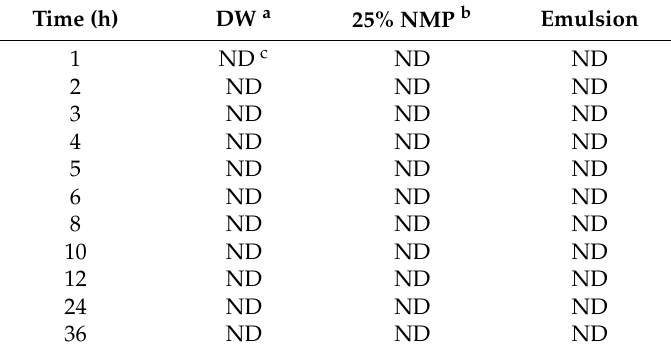
Table 1. Concentrations of melittin in receptor